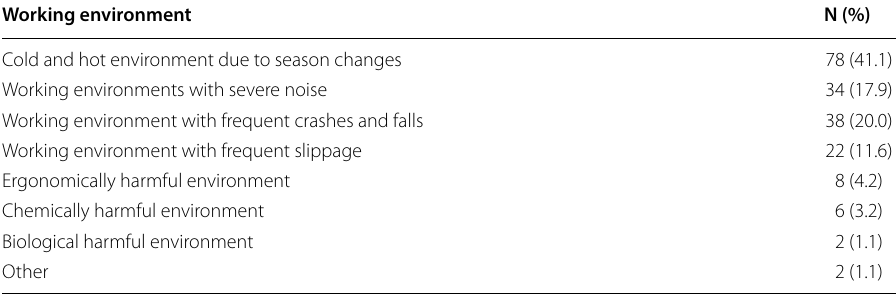
Table 4 Characteristics of working environment